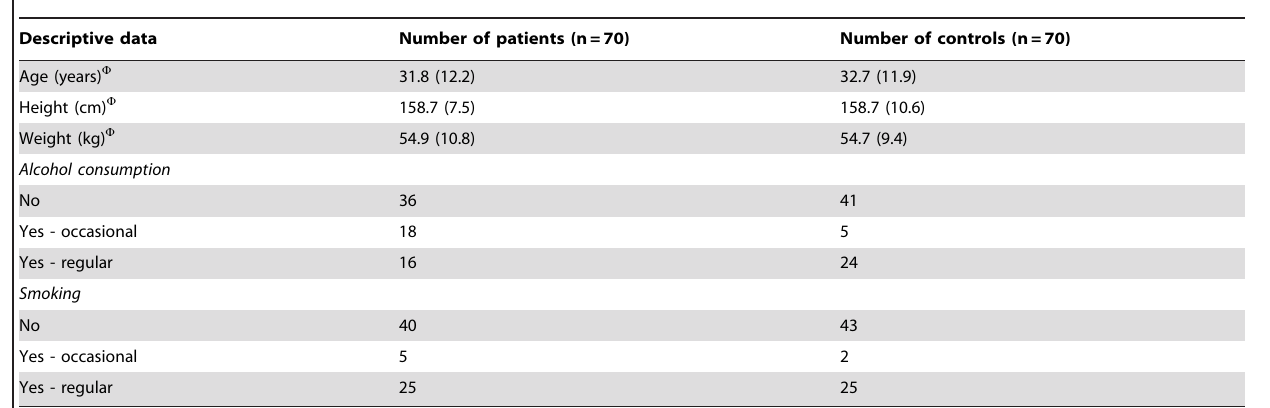
Table 1. Descriptive data of the patients and the